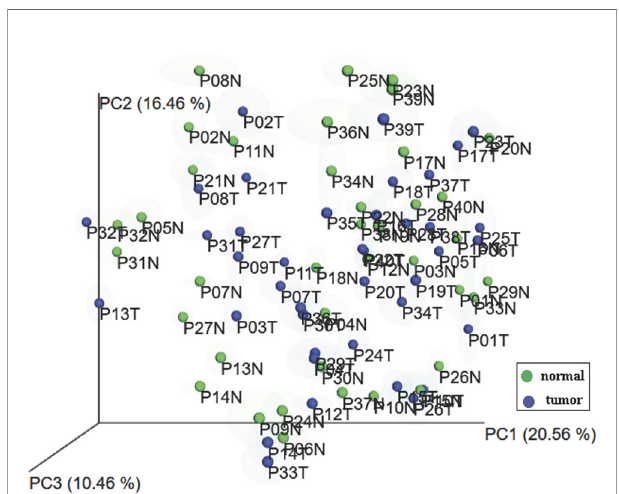
FIGURE 2 | Principal coordinates analysis plots of microbial community composition. Samples from each patient cluster closer together rather than separating into lesional and non-lesional skin groups.